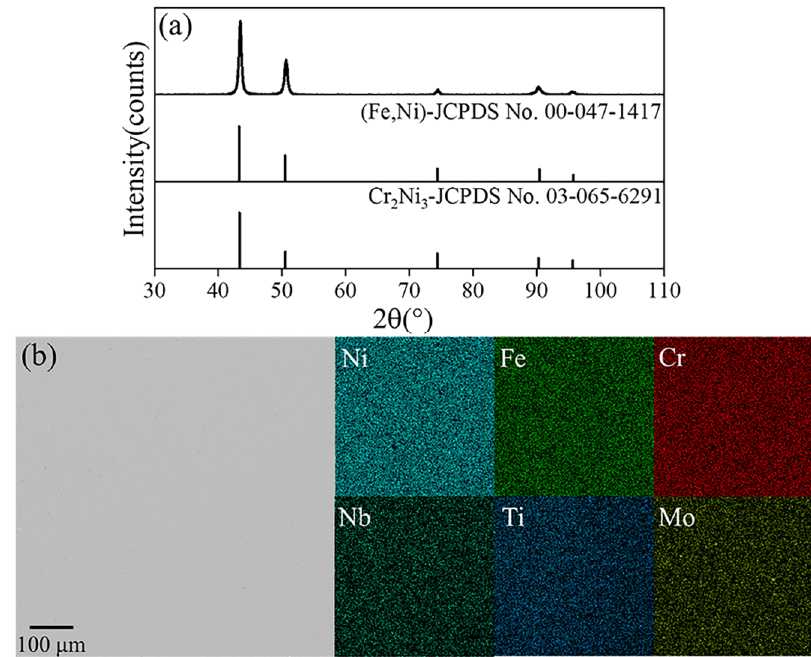
Figure 2. XRD patterns, SEM images and EDS mappings of the Ni-based superalloy: ( a ) XRD patterns; ( b ) SEM image and EDS mappings.